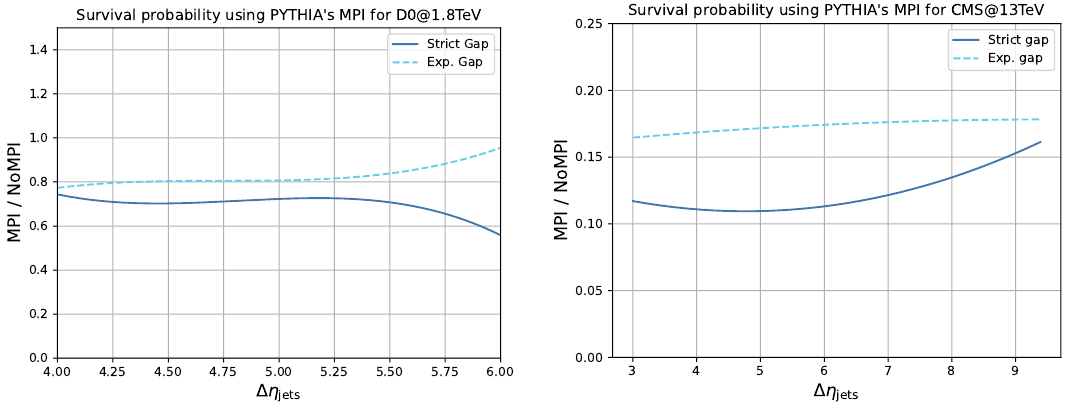
Figure 12 . Proxy for the survival probability calculated with the MPI of PYTHIA8 as a function of ∆ η between the jets. The jets on the left and right panels satisfy the D0 1.8 TeV and CMS 13 TeV jets dijet selection requirements, respectively. The solid blue curve shows the prediction for the strict gap, whereas the dotted-dashed cyan curve shows the prediction for the experimental gap. The tune CP1, ISR = on and SpaceShower:rapidityOrder = on settings are used for these